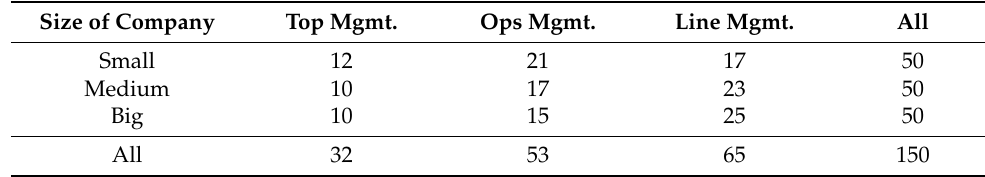
Table 2. Features of the defined